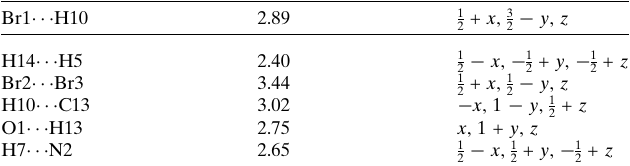
Table 2 Summary of short interatomic contacts (A˚ ) in the title compound.